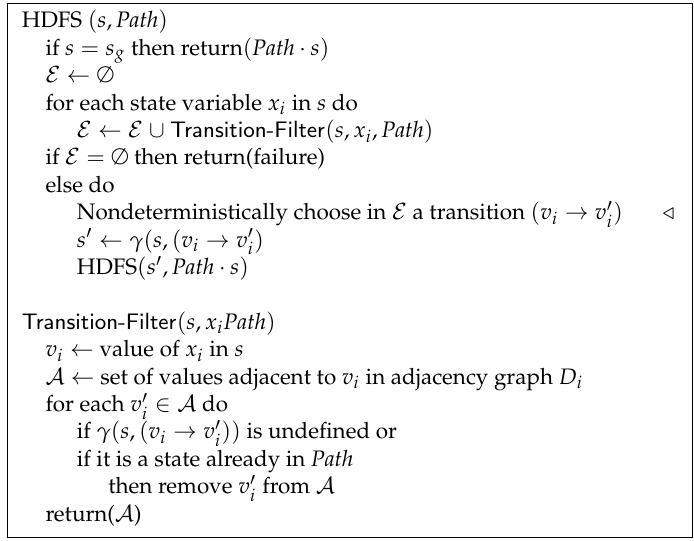
Figure 7. Main procedure as a recursive nondeterministic best-first search. The choice (in step (cid:47) ) is guided with the heuristic cost function used to order the set A . In the case of failure, backtracking is performed at this step to other remaining options in the set E , which is computed